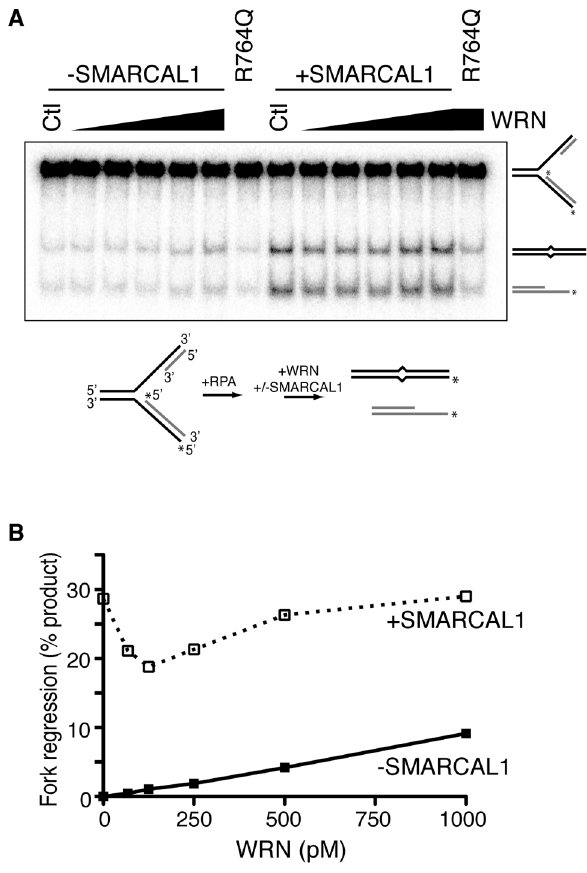
Figure 5. SMARCAL1 and WRN work independently to catalyze fork regression. Purified SMARCAL1 and WRN proteins were incubated with a 32 P-labeled model replication fork substrate capable of undergoing fork regression (see supplemental table S1). The substrate contains a 30-nucleotide ssDNA gap on the leading strand. RPA was pre-bound to the substrate prior to the addition of enzymes. (A) 500pM SMARCAL1 was used where indicated. The Ctl reactions lacked WRN protein to show the amount of spontaneous fork regression without SMARCAL1 or the amount of fork regression in the presence of only SMARCAL1. R764Q indicates reactions with the ATPase deficient SMARCAL1 R764Q mutant as a control. (B) Quantita- tion of the percent of product formed in each reaction. The amount of spontaneous branch migration in the absence of any added protein was subtracted from each